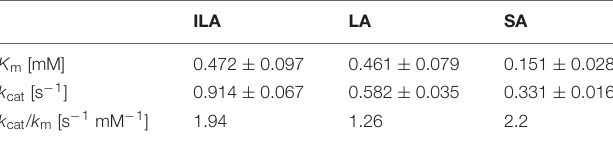
Enzyme reactions were performed using recombinantly expressed UGT76B1 and 14 C-labeled UDP-glucose together with ILA or LA as aglycon substrates to obtain k cat and K m values (see section “Materials and Methods”; n = 4, ± SE). Values with SA were determined based on the absorption of SA and SA glucoside at 302 nm (see section “Materials and Methods”; n = 3, ± SE). While K m values for ILA and LA were similar, k cat were significantly different (t-test, p = 0.005). The derived enzymatic efficiencies k cat /K m are indicated as